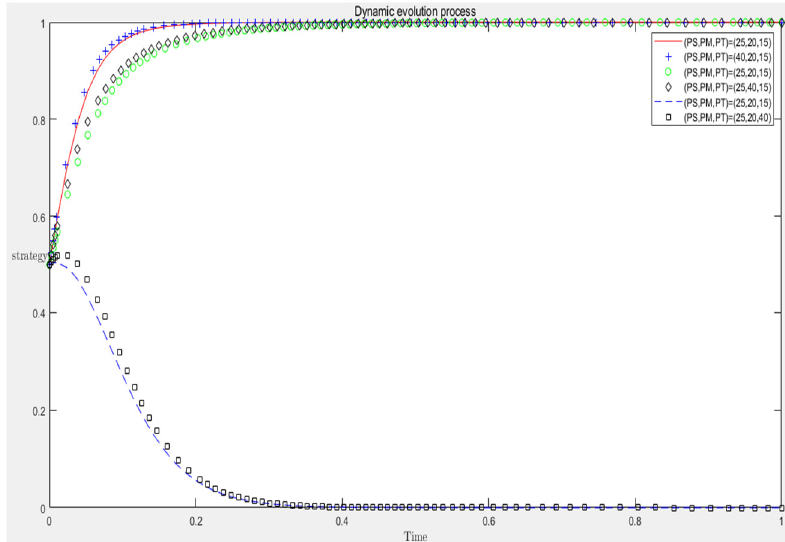
Figure 9. Influence of government